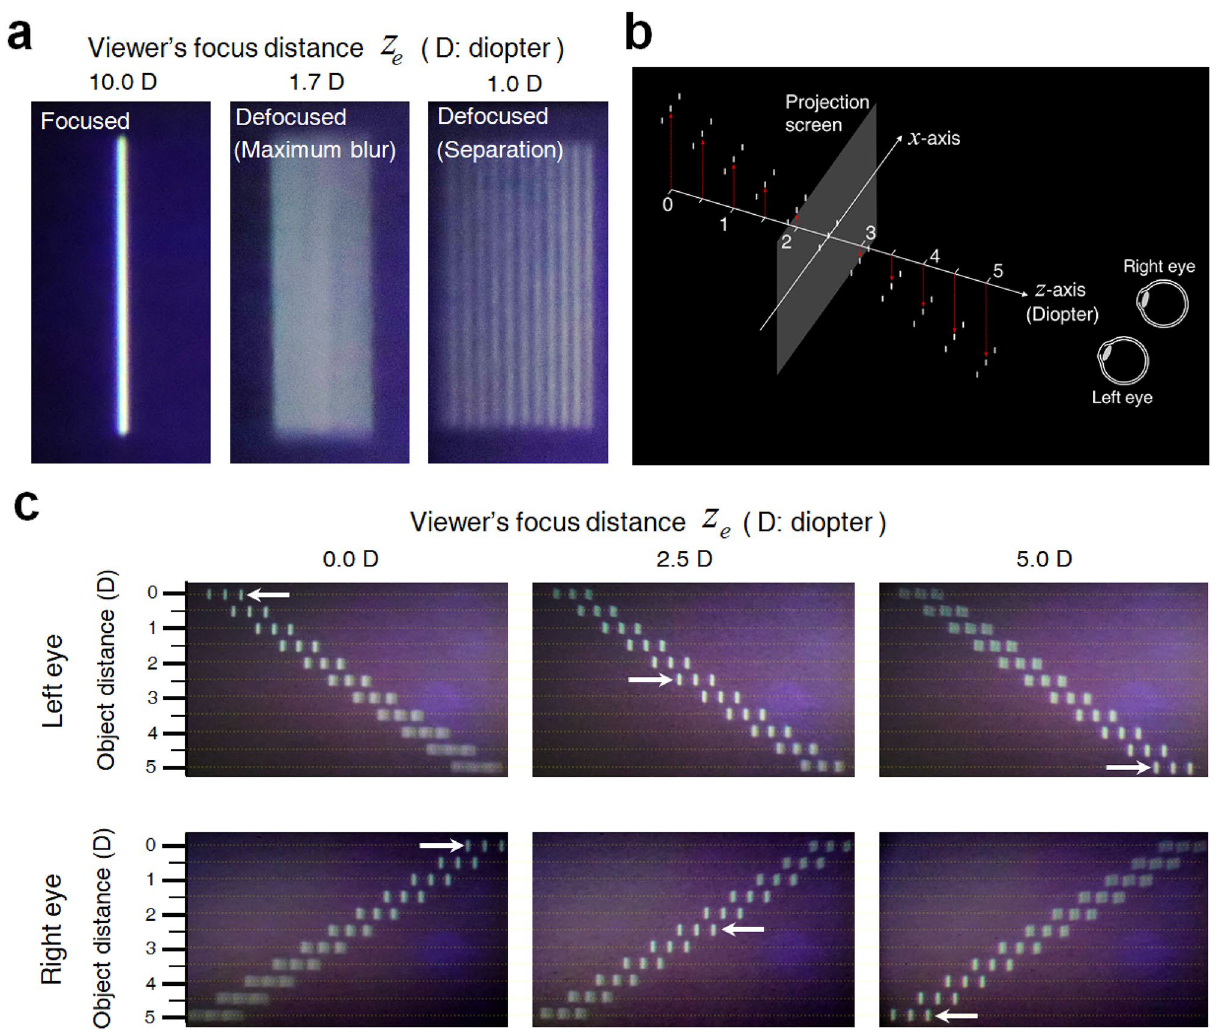
Figure 5. 3D images of vertical lines at various depths. ( a ) Monocular 3D images of a vertical line located at d obj = 100 mm depending on the viewer’s focus distance z e . ( b ) Experimental configuration of the vertical lines at different depths. Three vertical lines are arranged at object distance d obj from 5.0 to 0.0 diopters, at 0.5-diopter intervals. ( c ) Reconstructed 3D images of the vertical lines at different depths. z e is 0.0, 2.5, and 5.0 diopters, the vertical lines at an object distance of 0.0 diopters are in focus and other vertical lines are blurred. In this case, as expected, the vertical lines located at 5.0 diopters have the largest amount of blur. The natural blurring of the vertical lines is expressed without line separation. When z e is 5.0 diopters, accommodation is perceived at other object distances including 0.0 diopters. The vertical lines at an object distance of 0.0 diopters have the largest blur without the separation and the amount of blur in the vertical line gradually decreases according as the diopter increases. This means that the proposed BTS HDMSV projection system has a potential to display natural 3D objects located from 5.0 to 0.0 diopters. The vertical lines are placed at different depths, but they are all centered horizontally. Therefore, due to binocular disparity, when the viewer watches the vertical lines with either the right or left eye, the vertical line at the point where the vergence does not match appears to shift horizontally in different directions. Discrimination between the natural-VAC-free zone and the pseudo-VAC-free zone depends on z e . The out- of-focus images can be scored according to the amount of defocus blurring. Distinguishing the natural-VAC-free zone from the pseudo-VAC-free zone can be conducted using the two parameters specified in the retina plane: the maximum achievable blur width of one voxel c p , which is conceptually defined by the sum of the elemental view image blurring, and the desired natural true blurring of the same voxel, c o . c p is a function of z e and the number of VRPs N , while c o is the function of z e and the object distance d obj . The natural-VAC-free zone is judged by comparing c p ( z e , N ) and c o (cid:31) d obj , z e (cid:30) for a particular value of z e . When c p ( z e , N ) for a given z e is smaller than c o (cid:31) d obj , z e (cid:30) for a voxel at a certain d obj , the defocused image of the voxel appears as an overlapped image of separate pieces of elemental view images, as shown in the right panel of Fig. 5a, and the voxel is thus located in the pseudo-VAC-free zone. On the other hand, if c p ( z e , N ) is greater than or equal to c o (cid:31) d obj , z e (cid:30) , the blurring of the voxel located at d obj can be expressed without separation for a given z e . In this case, the voxel is located in the